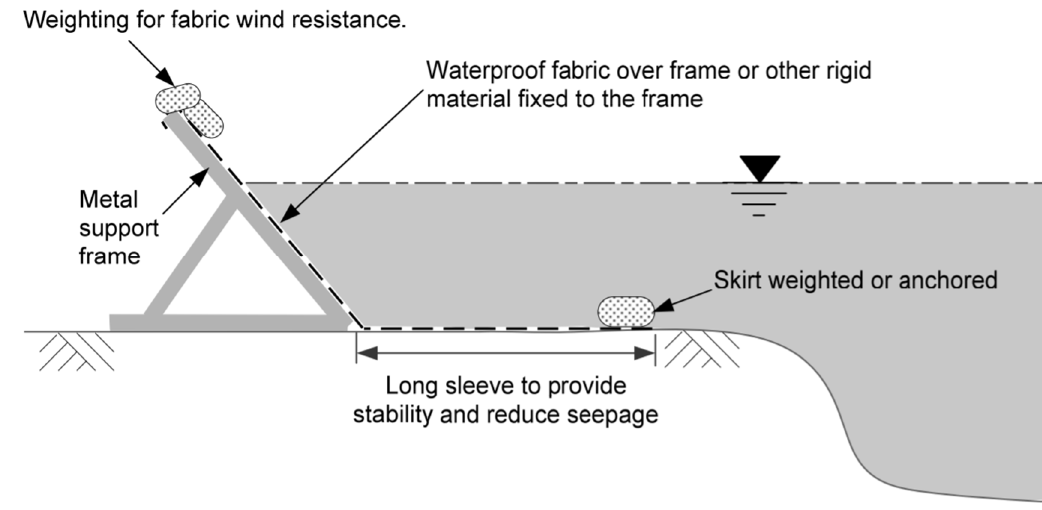
Figure A3. Frame barrier, derived from Ogunyoye et al. [19].